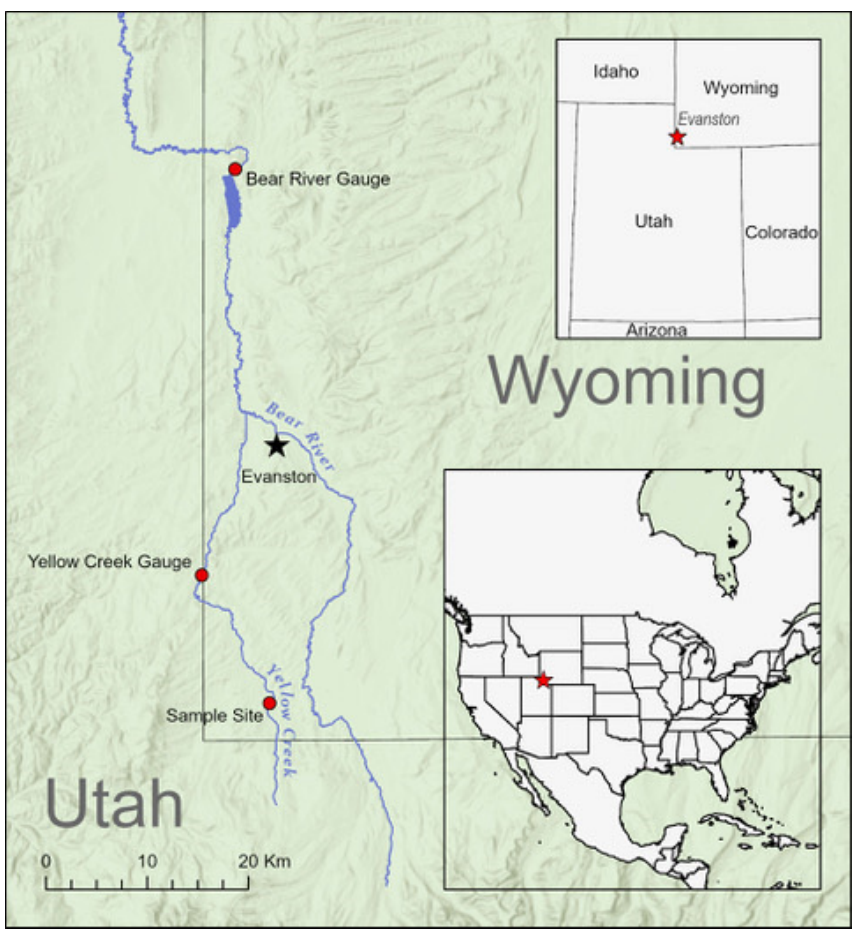
Figure 1. Map of study site and stream gauge locations. Insets and red star illustrate general location of study site in North America. Yellow Creek and the Bear River both originate in the Uinta Mountains of northern Utah and flow northward before their confluence near Evanston, Wyoming, USA (black star). Red dots indicate the sample site and the location of the Yellow Creek Gauge and the Bear River Gauge referenced in Figure 2.